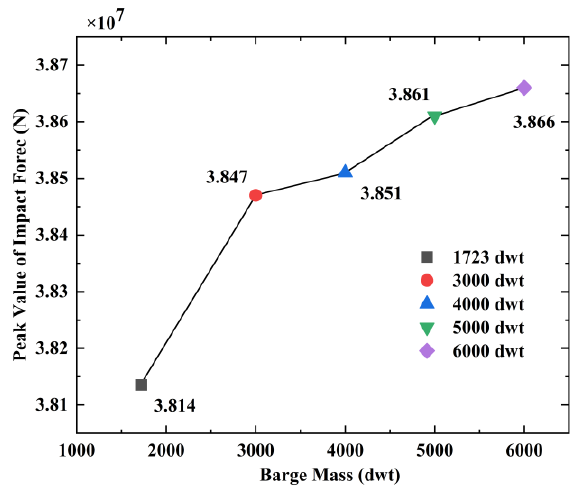
Figure 20. Variation of peak values of impact force under different barge masses.